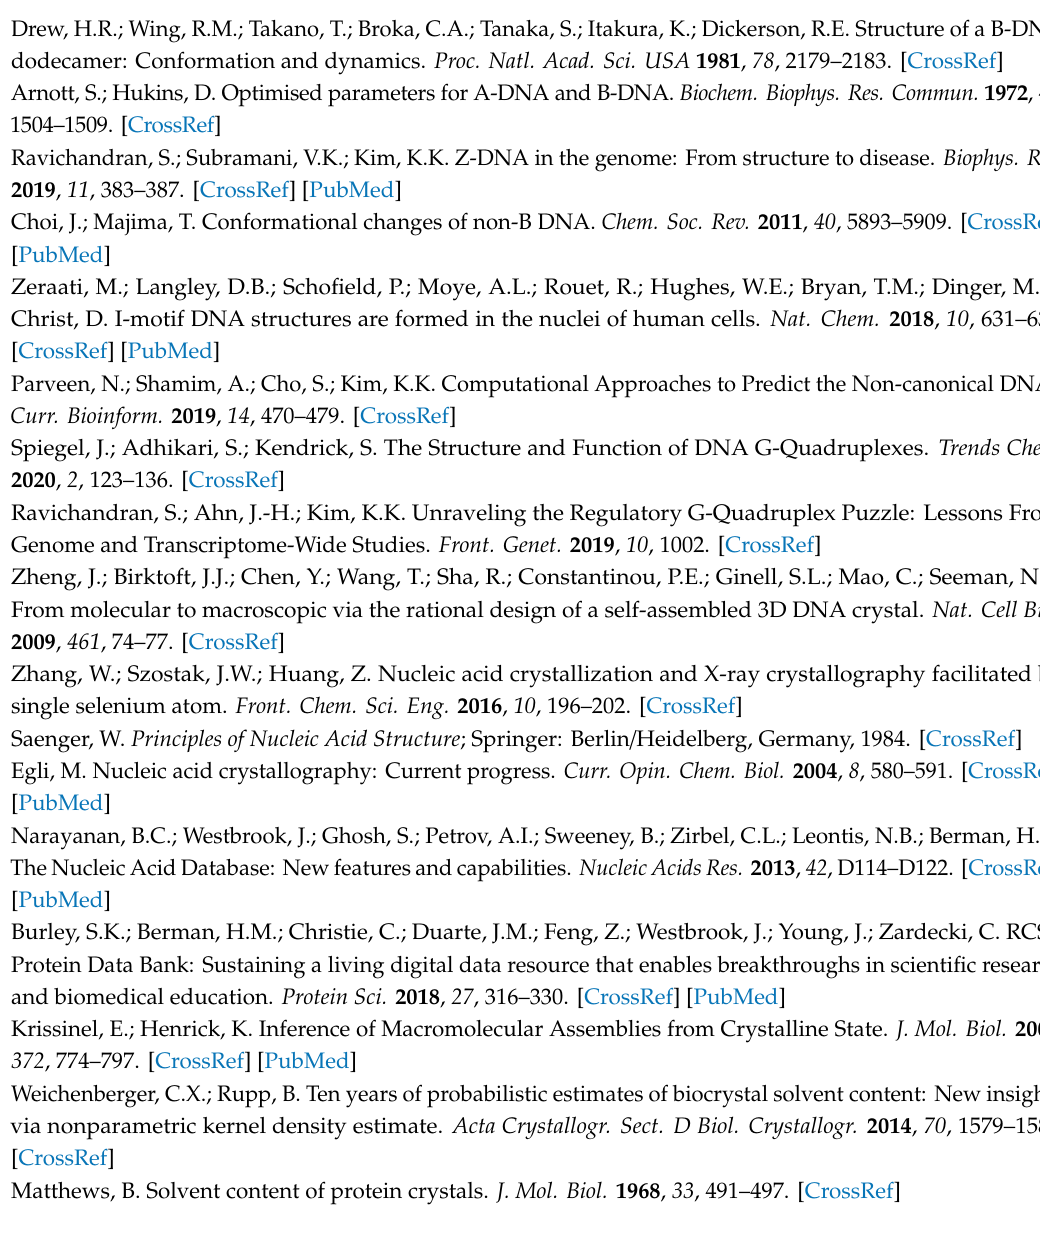
Table S1: Entire Dataset; Table S2: Correlation matrix; Table S3: Packing type vs. Conformation; Table S4: Sequence length vs. Packing type, Conformation, Resolution; Table S5: Packing type vs. Sequence composition; Table S6: Packing type vs. Interacting bases and entity; Table S7: Resolution vs. Packing type, Conformation; Table S8: Symmetry vs. Packing type, Conformation, Sequence length, Resolution; Table S9: Metal / Ligand vs. Packing type, Conformation, Sequence Length, Resolution; Table S10: Solvent content vs. Packing type, Conformation, Sequence length, Resolution, Symmetry, Metal / Ligand, Sequence; Table S11: Packing type vs. Populous Symmetry